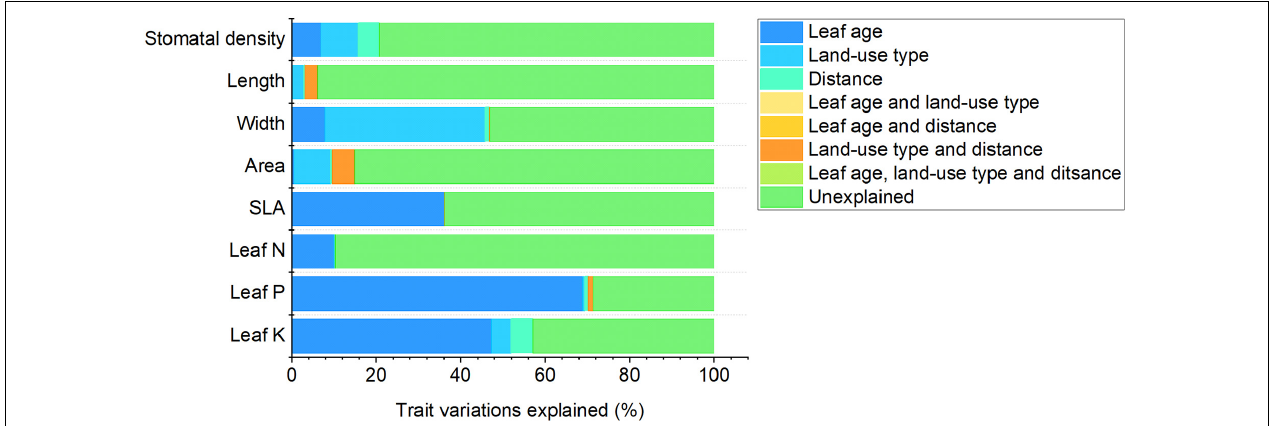
FIGURE 4 | Variations in leaf functional traits explained by leaf age alone, land-use type alone, distance from the city center alone, and the intersection of these three factors, based on variation partitioning analysis.